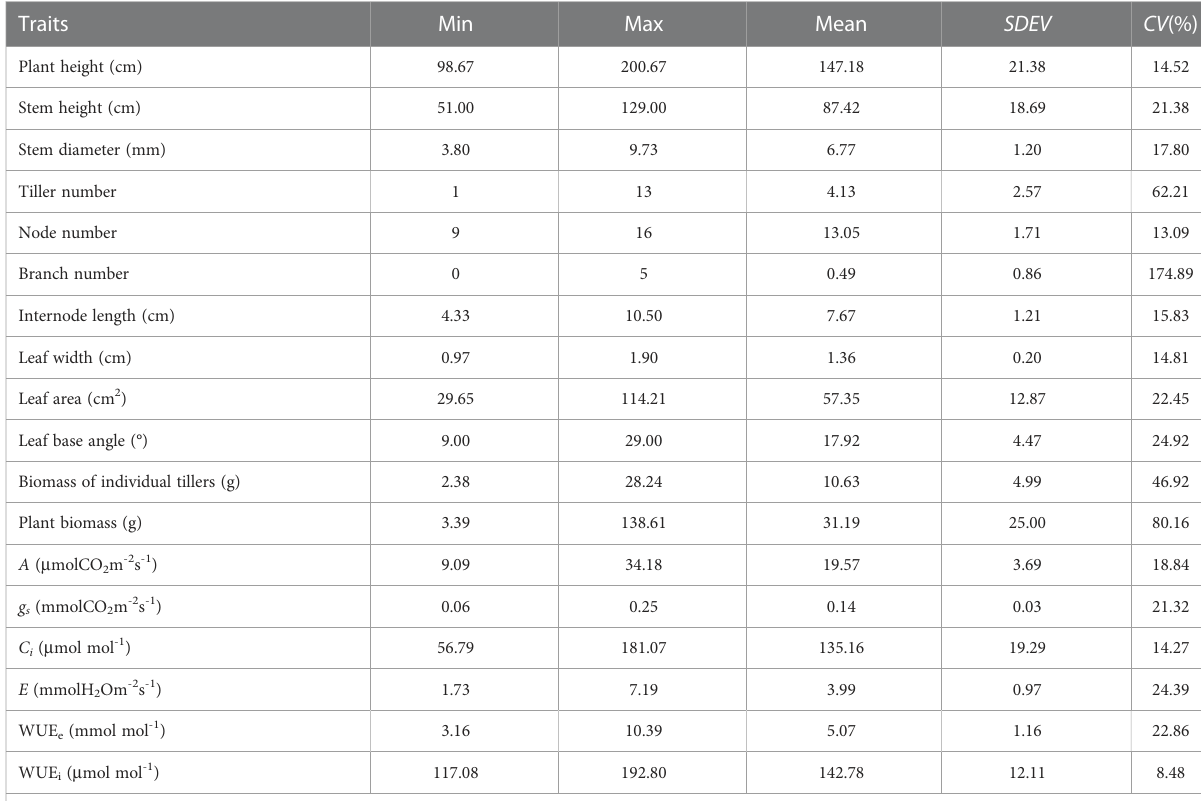
Atotalof333individuals of113hybridgenotypesare calculated. MinandMax representtheminimumandmaximum inall valuesoftraitsmeasured, respectively. Meanistheaverage value to all values of traits measured. SDEV is the abbreviation of standard deviation. CV represents the variable coef fi cient. A: Photosynthetic rate, g s : Stomatal conductance, C i